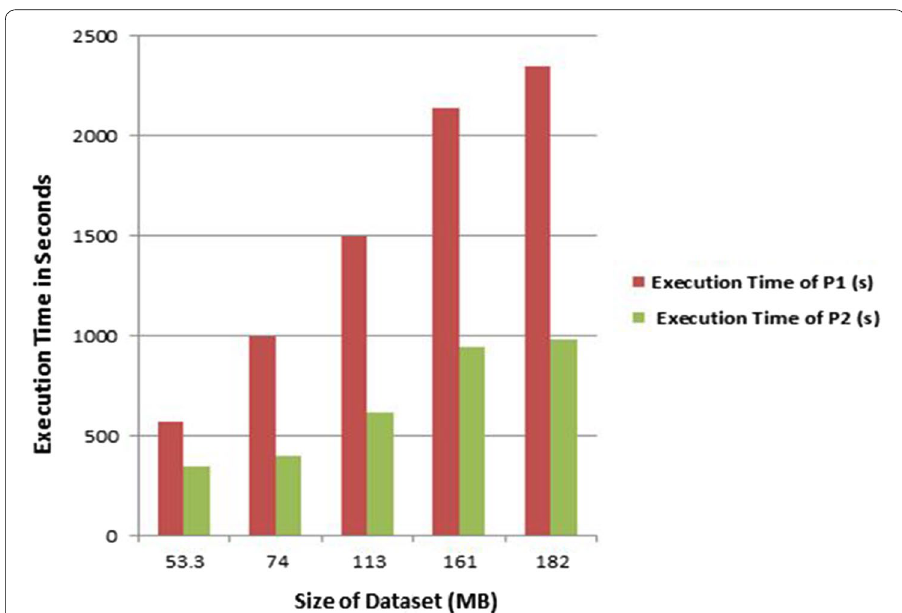
Fig. 3 Execution times vs dataset sizes of the different servers hosting